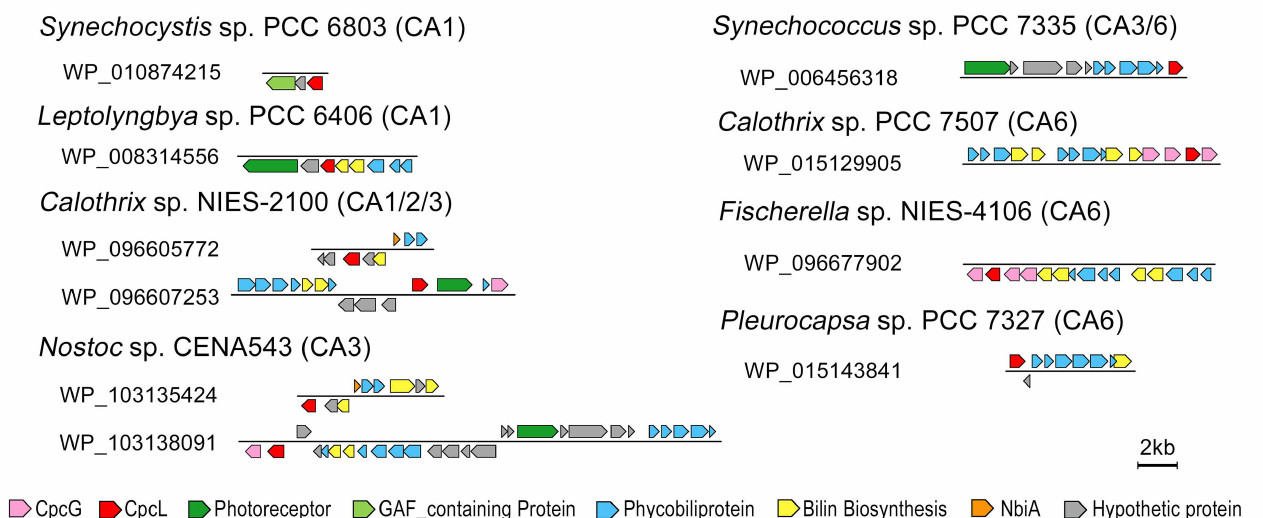
Figure 5. Associated gene locus containing cpcL from representative